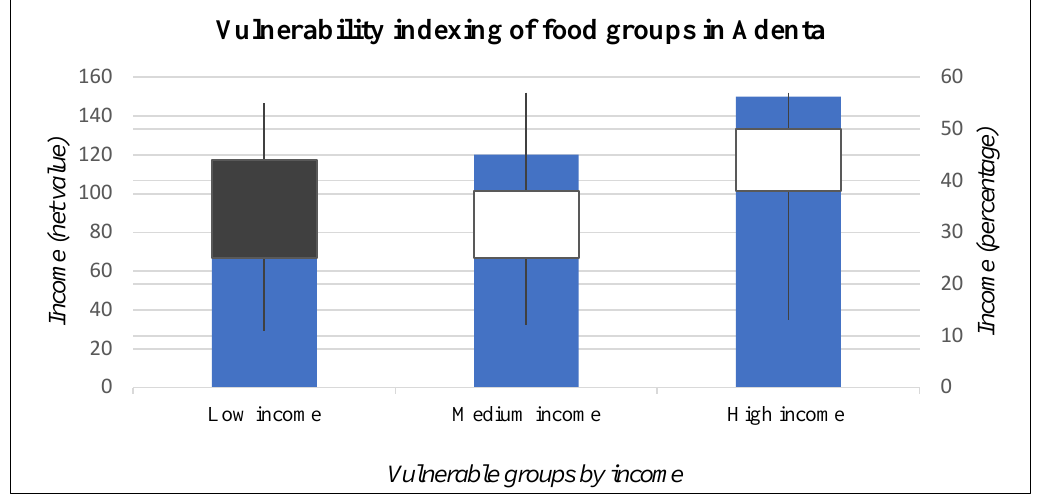
Figure 8. Vulnerability indexing of food groups in Adenta municipality (Source: Adenta Municipality medium term report, 2017).